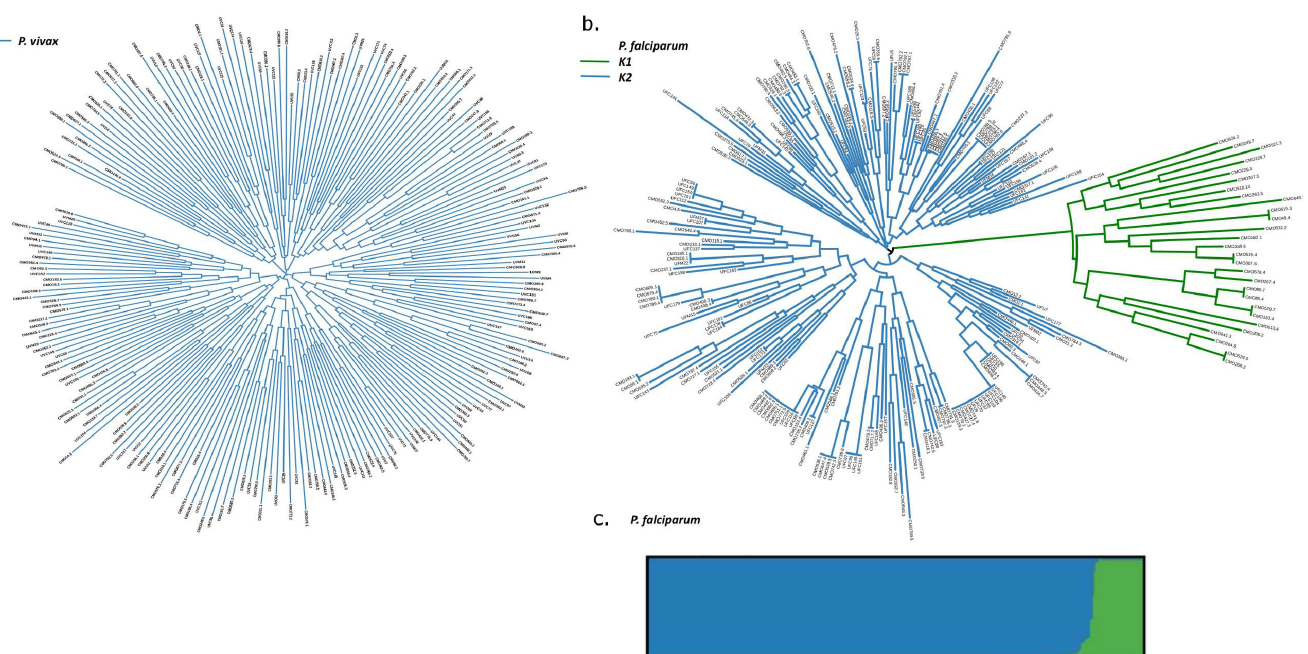
In contrast to P . falciparum , no substructure was found in the P . vivax population. The neighbour-joining analysis (Fig 1A) illustrates that the P . vivax isolates exhibited low